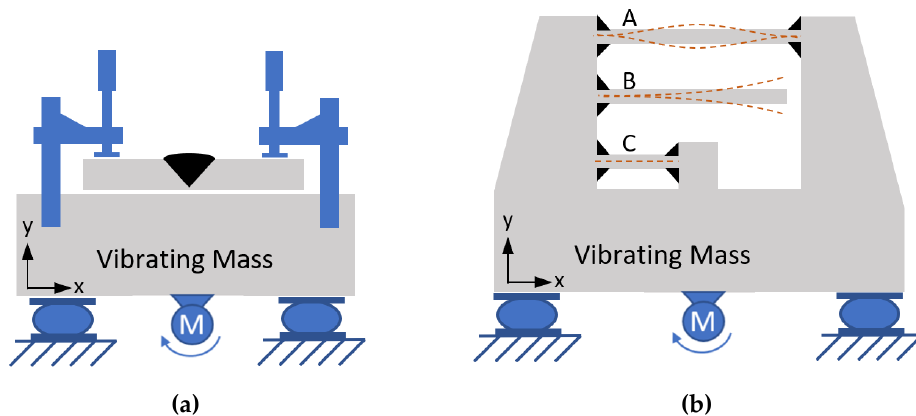
Figure 1. Local vibrational e ff ect (LVE) setup vs. global vibrational e ff ect (GVE) setup. ( a ) A weld coupon is clamped to a vibrator, which is supported by dampers. The weld joint area will experience the same rigid-body motion as the vibrator (LVE). ( b ) A large infinitely-rigid base to which three beams are welded. Assuming the same-section properties, the natural frequencies of the three beams are